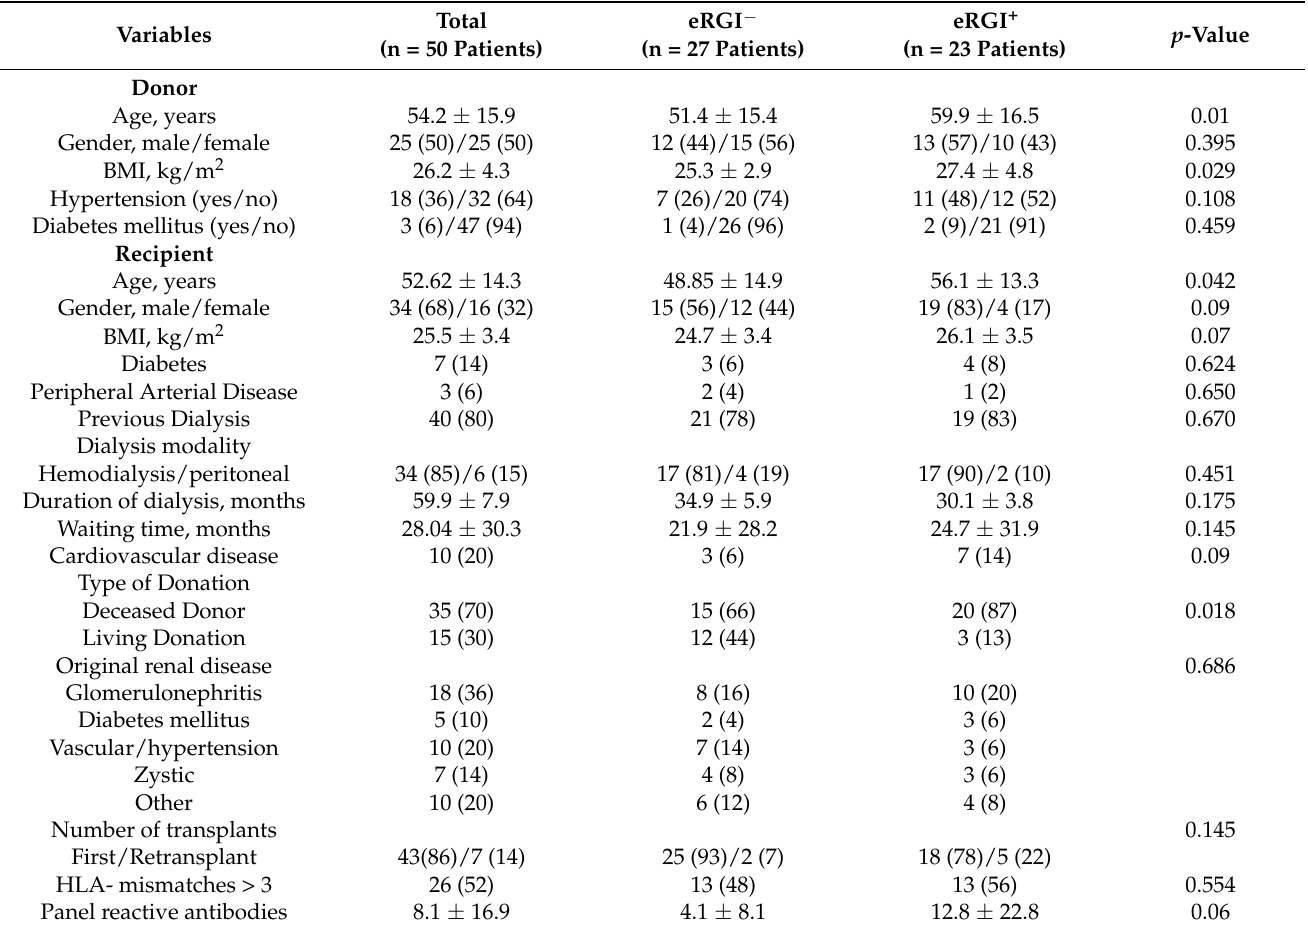
Table 1. Baseline transplant characteristics of recipient and donor according to the status of early renal graft injury